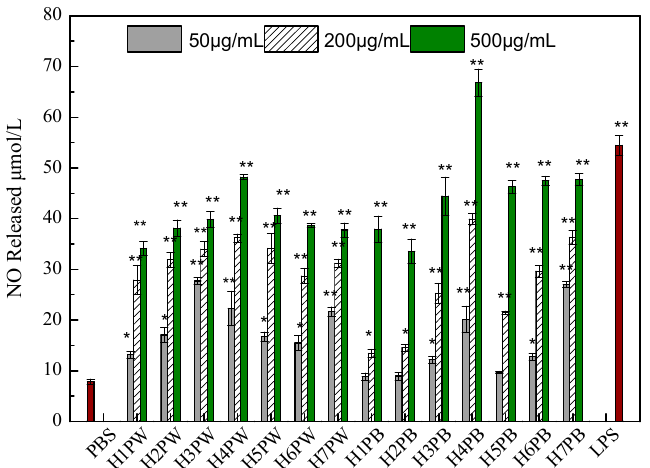
Figure 5. Effect of fruiting body maturity stage on NO production in murine macrophage-like cells RAW264.7. Cells (5 × 10 5 cells/mL) were stimulated by cell wall polysaccharides. Supernatants were collected and NO production was determined using the Griess reagent. Each value represents the mean ± SD. * p < 0.05, ** p < 0.01 compared to the negative control (PBS treatment).